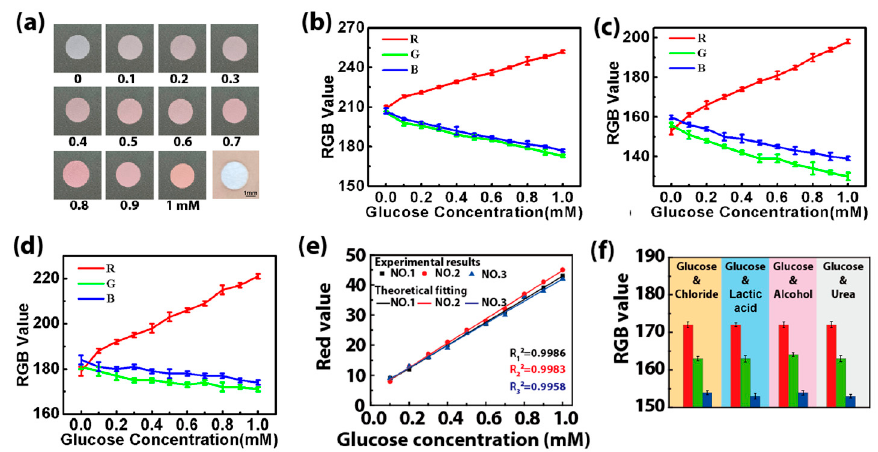
Figure 8. ( a ) Pictures of the color markers with different concentrations of glucose solution (0.1–1 mM). ( b – d ) The RGB value when the color markers are illuminated with different kinds of light: ( b ) 2.5 W white light, ( c ) 5 W white light and ( d ) 3 W yellow light. ( e ) The final reference curves obtained by fitting the R values of the color markers with different concentrations of the glucose solution under different kinds of light irradiation (no. 1: 2.5 W white light, no. 2: 5 W white light, no. 3: 3 W yellow light). ( f ) The RGB values of color markers when chloride (0.3 mM), lactic acid (0.3 mM), alcohol (0.3 mM) and urea (0.3 mM) were added into the glucose solution (0.3 mM). The standard deviation was calculated from six test results at the test areas for each volunteer.